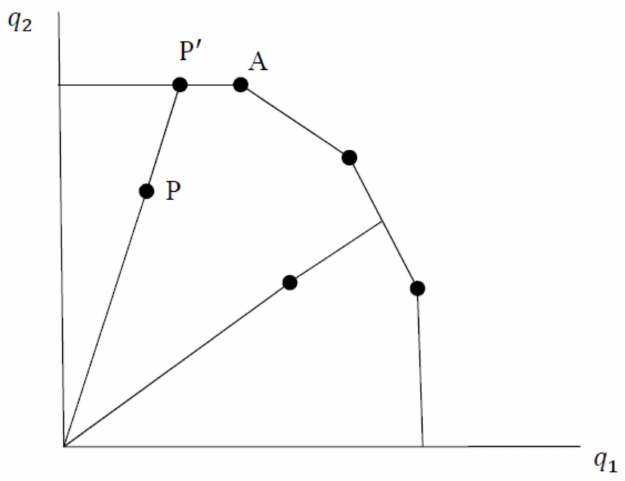
Figure 7. Output-oriented VRS-DEA